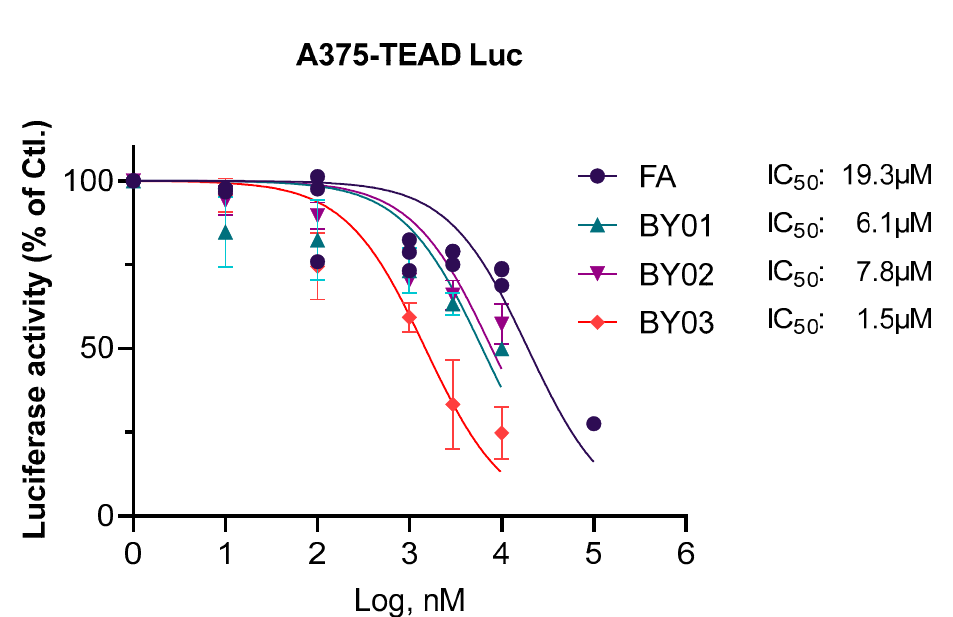
Figure 6. TEAD reporter luciferase activity observed in A375 cells treated with 10 nM to 10 μ M of hit compounds with FA (flufenamic acid) 24 h post-transfection ( n = 3).